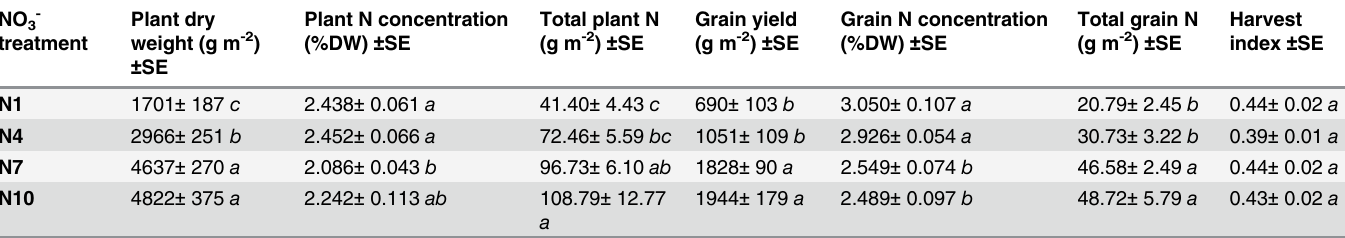
Values are the means of four biological repetitions ± 1 standard error (SE). Statistically non-signi fi cantly different groups (Tukey multiple comparisons, p < 0.05) are labeled with the same lowercase